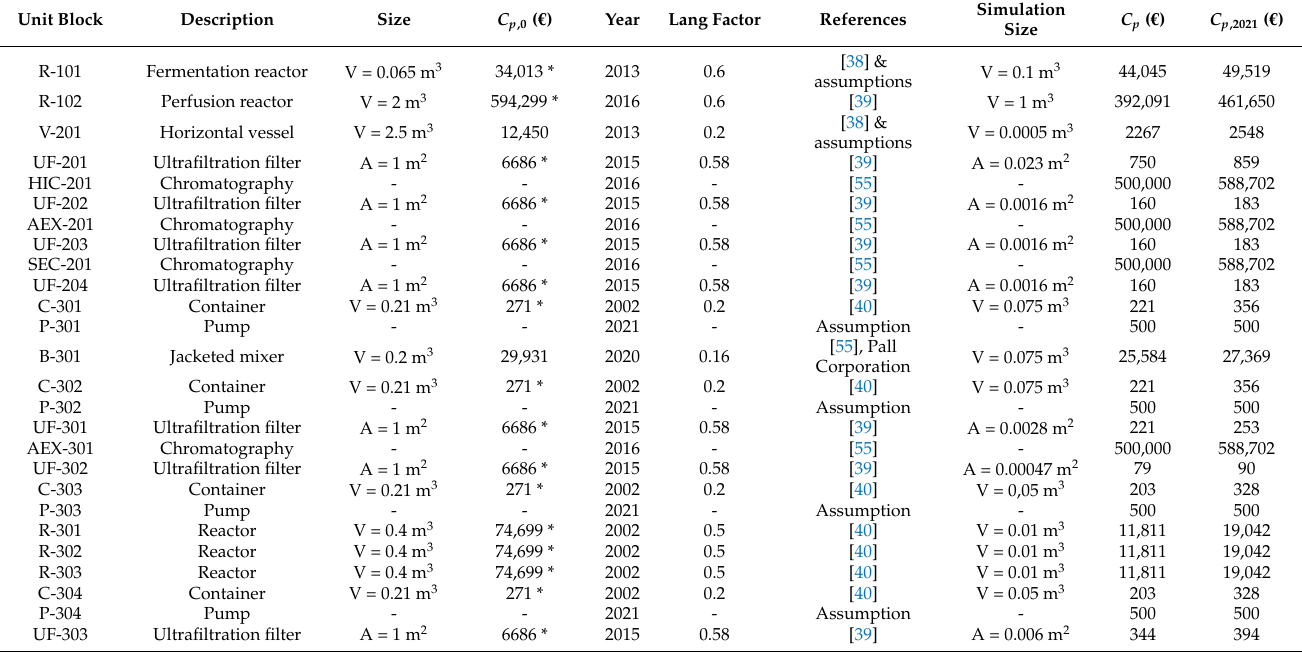
Table 8. Equipment sizing and cost.